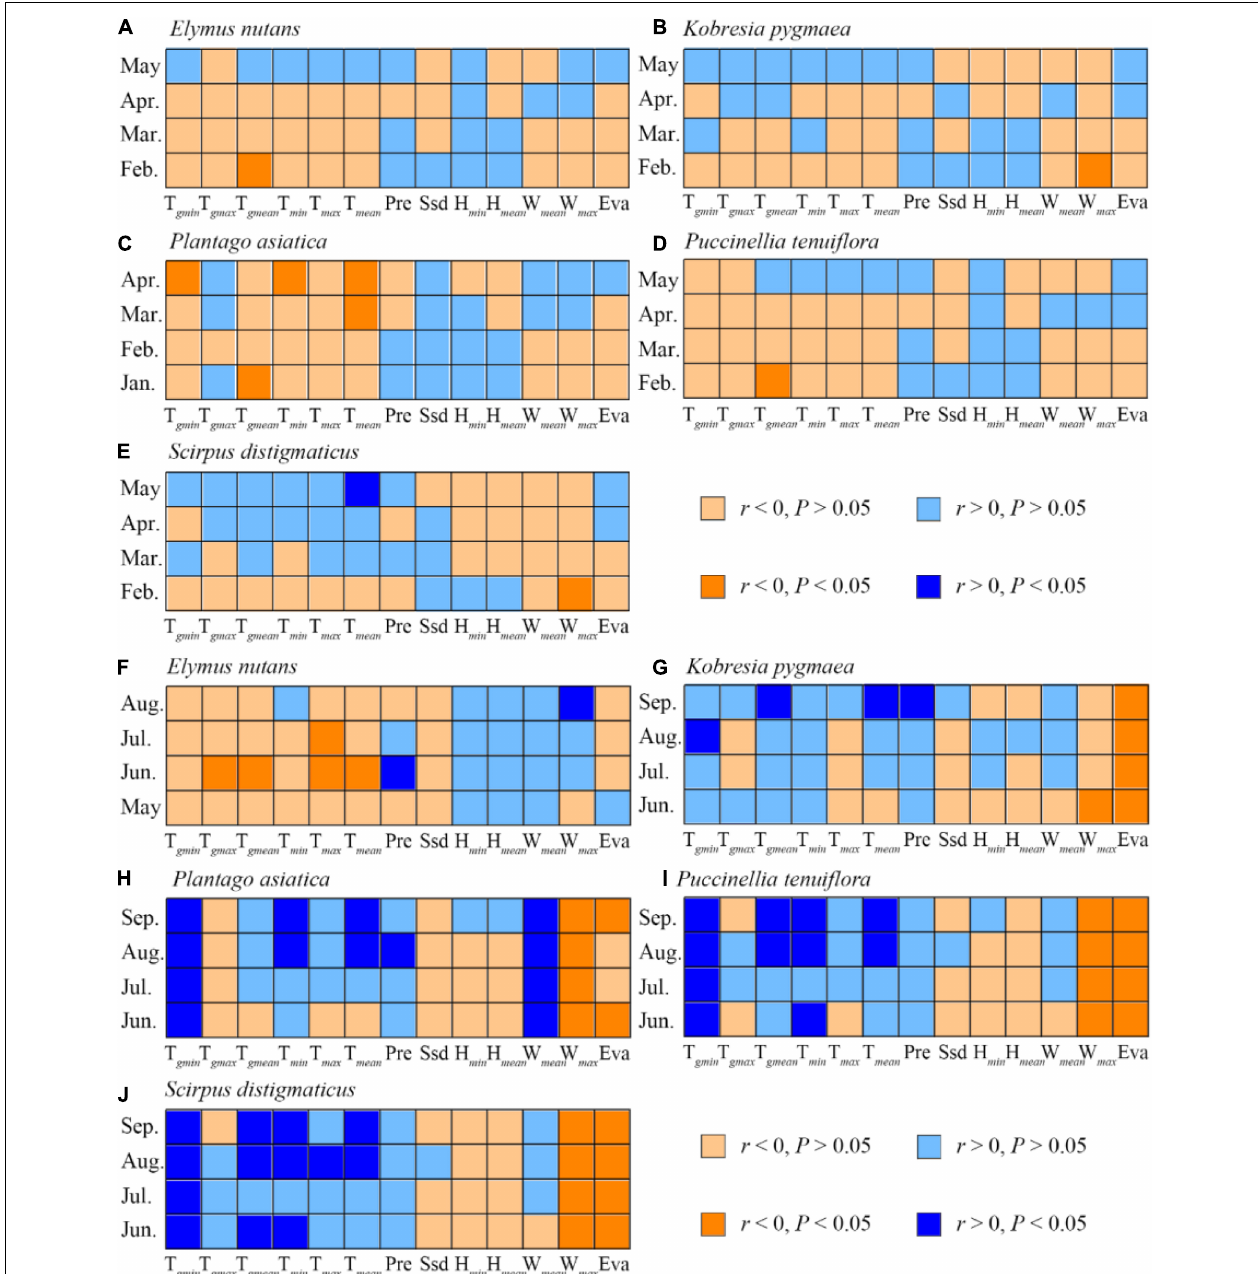
FIGURE 4 | Pearson correlation coefficients ( r ) between five herbs green-up/brown-off dates and climatic factors mean/accumulation values in annual mean green-up/brown-off date month and its pre 3 months. Panels (A–E) are green-up dates for Elymus nutans , Kobresia pygmaea , Plantago asiatica , Puccinellia tenuiflora , and Scirpus distigmaticus , respectively. Panels (F–J) are brown-off dates for them. T gmin , T gmax , T gmean , T min , T max , T mean , Pre, Ssd, H min , H mean , W mean , W max , and Eva represent daily minimum/maximum/mean 0 cm ground temperature, daily minimum/maximum/mean air temperature, daily precipitation, daily sunshine duration, daily minimum/mean relative humidity, daily mean/maximum wind speed, and daily evaporation, respectively. Details of the statistics of the Pearson correlation coefficients could be found in Supplementary Table 7